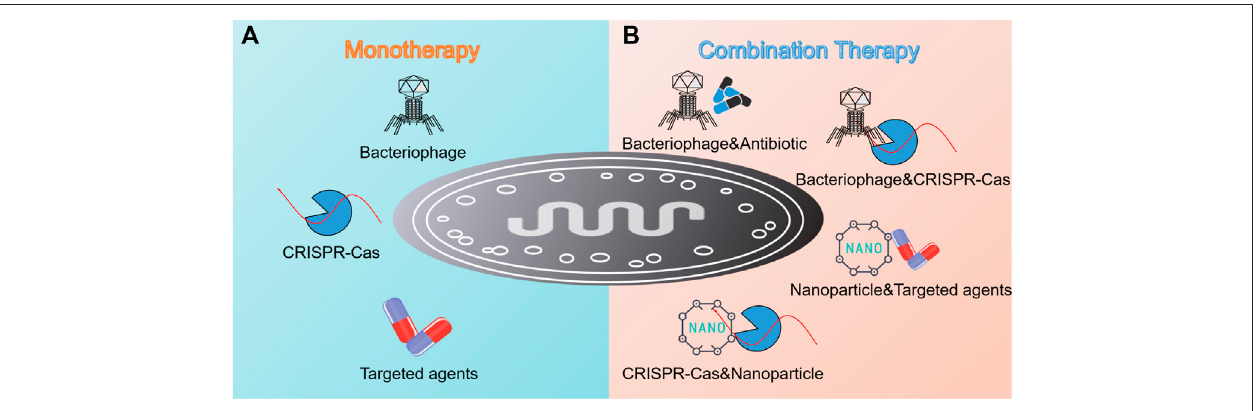
FIGURE5| Summaryoftargetedmonotherapyandcombinationtherapyagainstpathogenicbacteria. (A) Monotherapyinvolvestheinvasionofbacteriophage,the employment of CRISPR-Cas technology, and the utilization of targeted antimicrobial agents such as antibiotics, lysins, antibodies, and AMPs. (B) Combination therapy shows its advantages as re fl ected in the combination of bacteriophage and antibiotic, bacteriophage and CRISPR-Cas technology, nanoparticles and targeted antimicrobial agents, and CRISPR-Cas technology and nanoparticles.